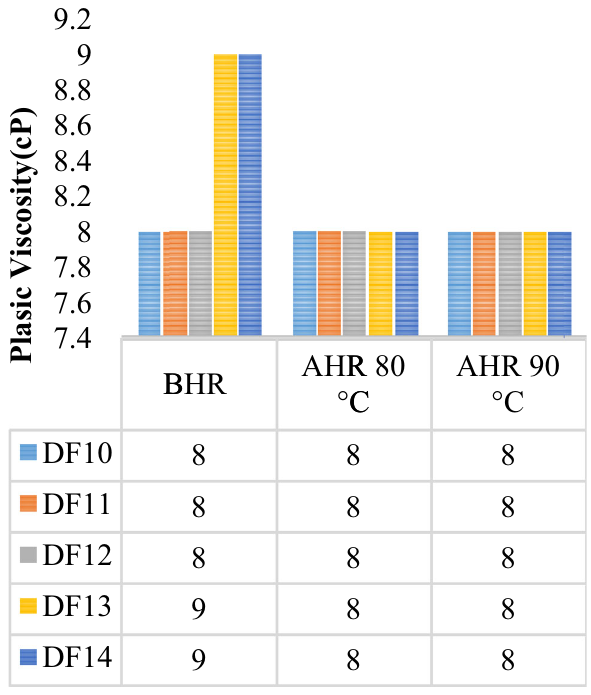
Fig. 11 Variation of PV after hot rolling